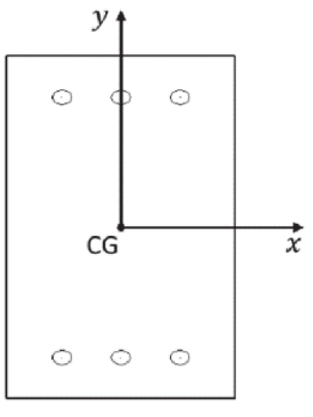
Seção transversal de pilar de concreto